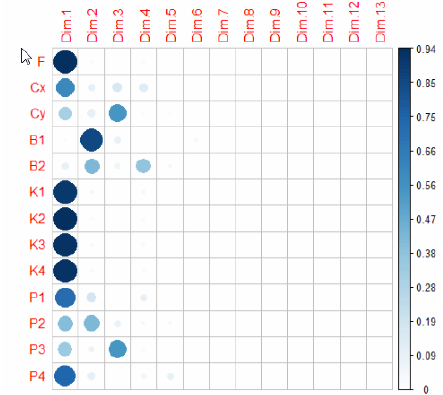
Figure 7. Correlation plot between camera calibration paramaters and principal components extracted by processing the dataset acquired in March. F: focal length; Cx and Cy coordinates of the principal point offset; B 1 , B 2: Skew parameters; k1, k2, k3, k4: radial distortions; p1, p2, p3, p4: components of the decentring distortions; Dim.1-Dim.13: principal components.